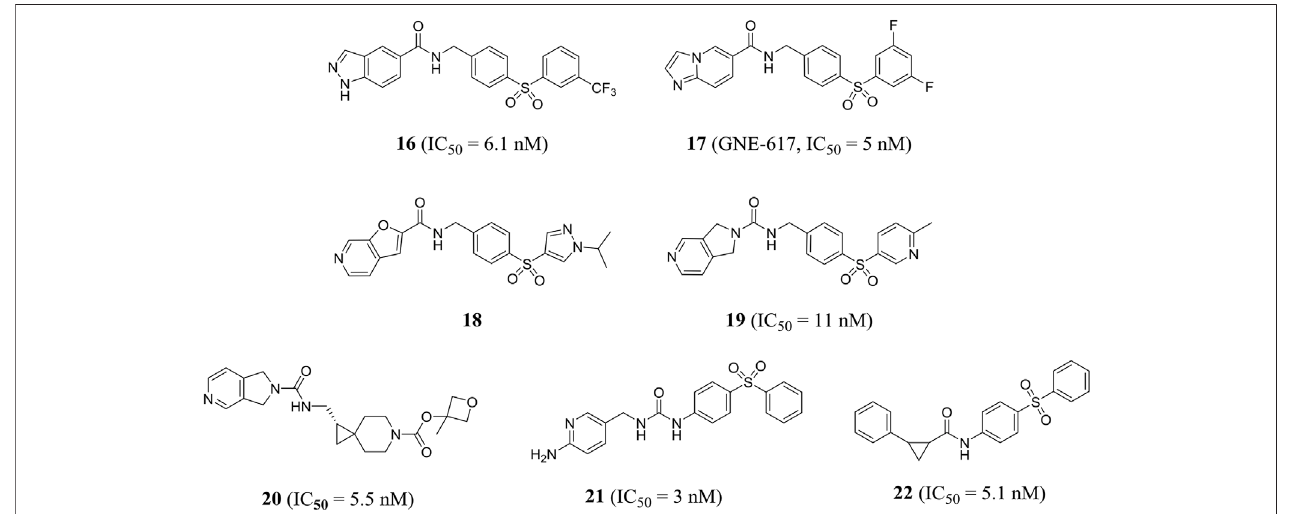
FIGURE 6 | Chemical structures and kinase activities of NAMPT inhibitors 16 – 22